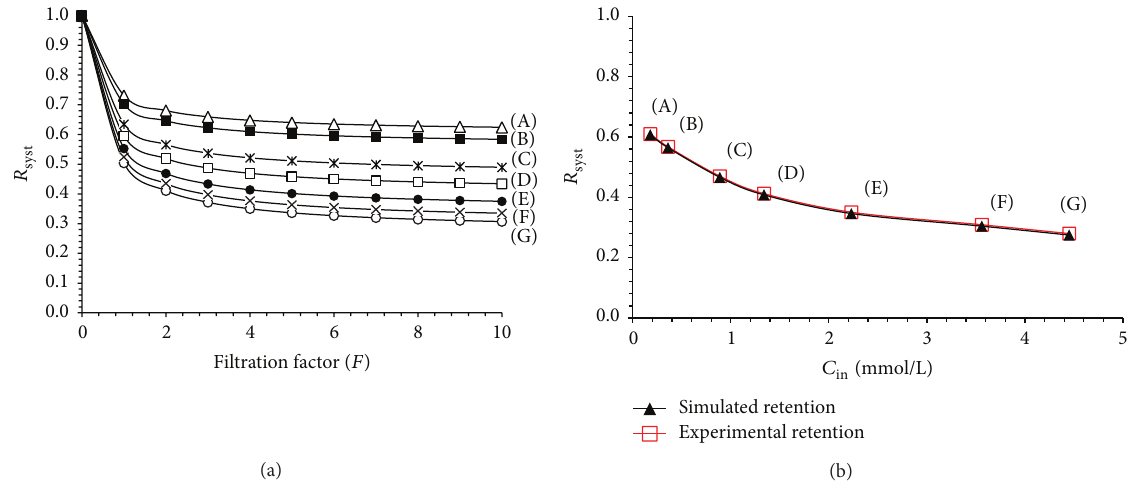
Figure 5: (a) Retention profiles and (b) modeling of 𝑅 0.36 (B), 0.89 (C), 1.34 (D), 2.23 (E), 3.56 (F), and 4.45